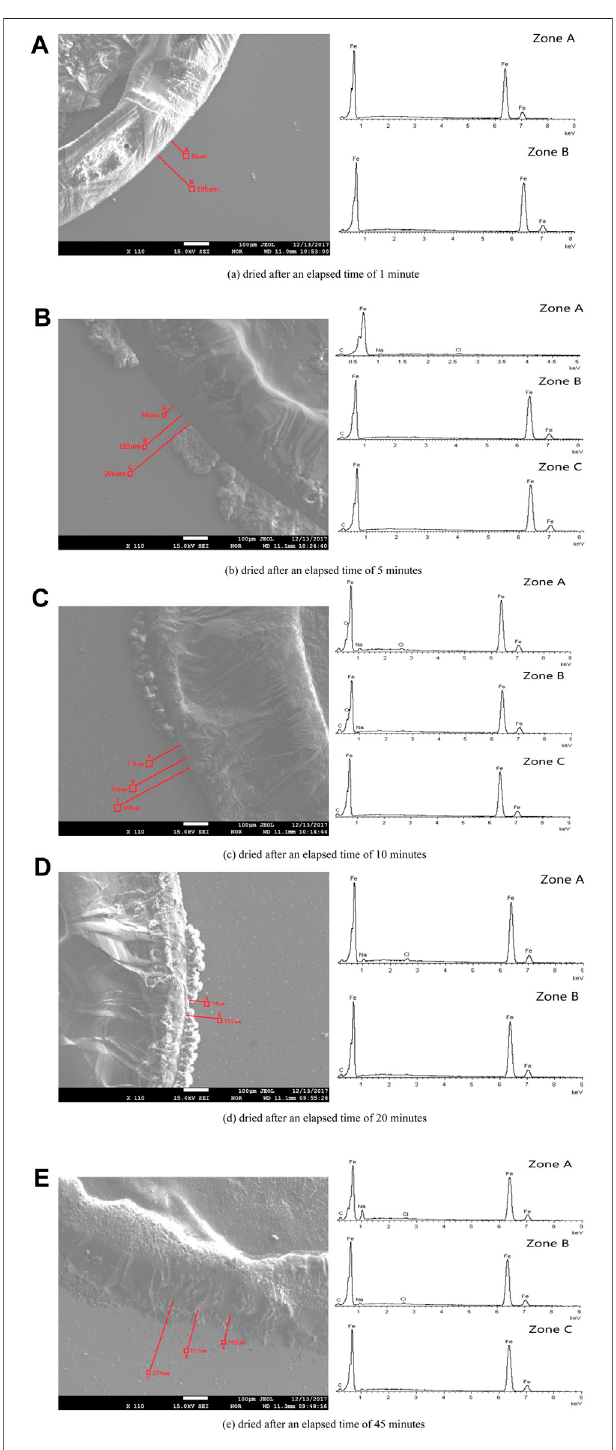
FIGURE 7 | SEM images of the dried specimen ’ s surface and EDS results of the speci fi c region marked on the left hand fi gure for different elapsed times after dropping the primary droplet. (A) Dried after an elapsed time of 1 min. (B) Dried after an elapsed time of 5 min. (C) Dried after an elapsed time of 10 min. (D) Dried after an elapsed time of 20 min. (E) Dried after an elapsed time of 45 min.